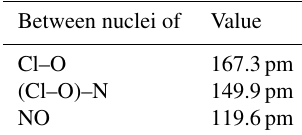
Table 2. Bond lengths of ClONO 2 , from Rankin and Robertson (1994).